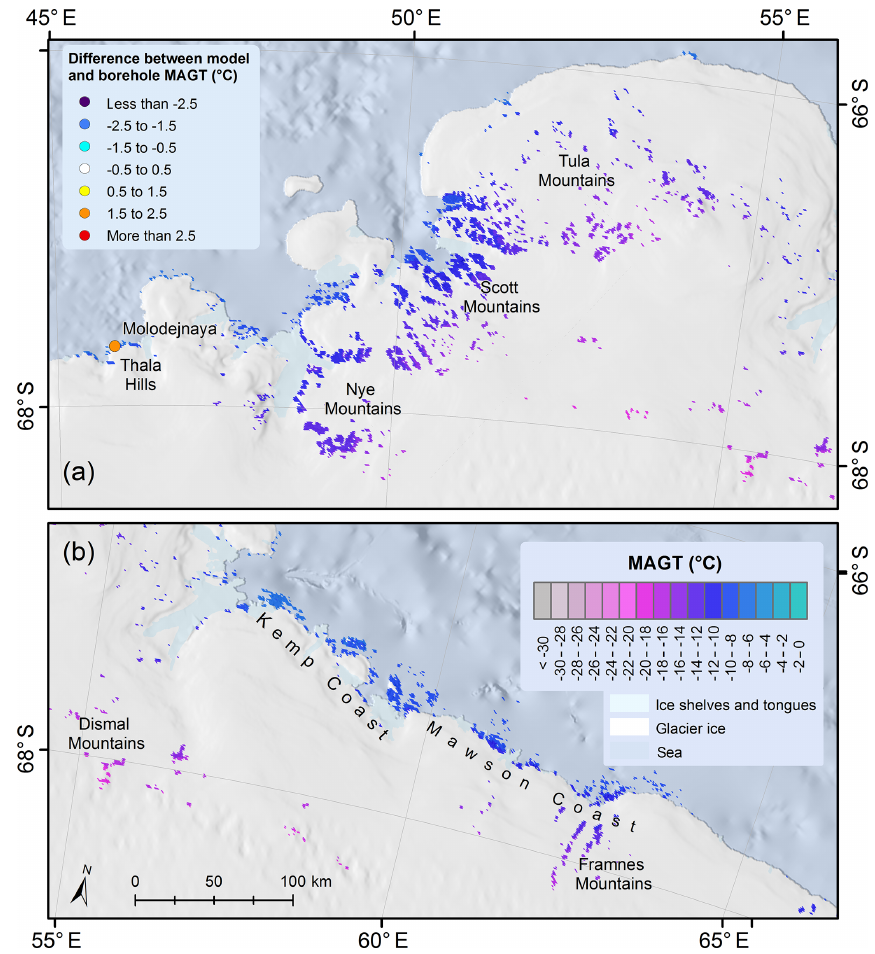
Figure 4. Permafrost temperature maps of Enderby Land and differences between borehole and modelled MAGT. Legends, scale and north arrow are valid for both panels. See Fig. 1 for location of panels (a) and (b)